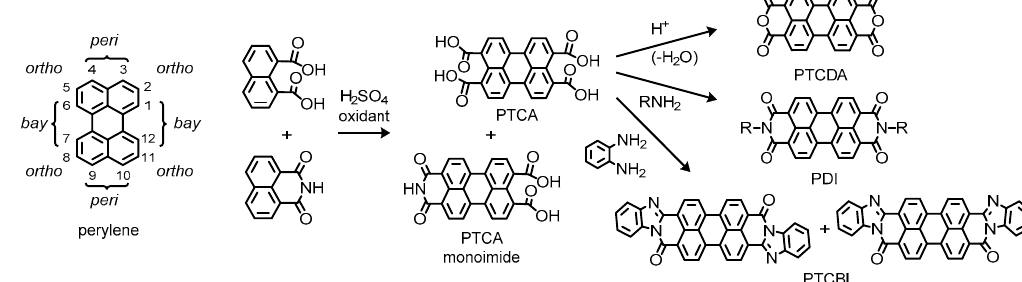
Figure 1. Chemical structures of perylene and related compounds. Positional prefixes for the perylene ring system are indicated in the left side of the figure.